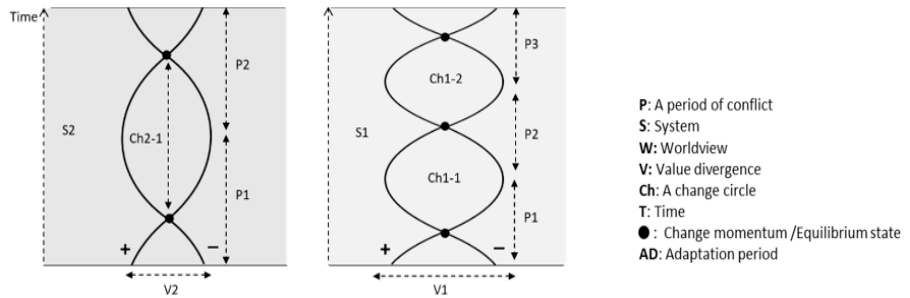
Figure 2. Conceptual visualization of controversies in social systems: the speed and rate of transfor- mation are subjected to time and context and are entangled with the outcomes of conflict as a process of change.